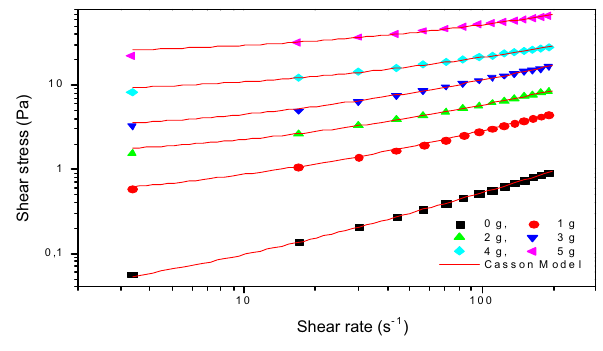
Fig. 6 Storage modulus G ′ and loss modulus G ″ as a function of shear stress for different quantities of VG69 organophilic